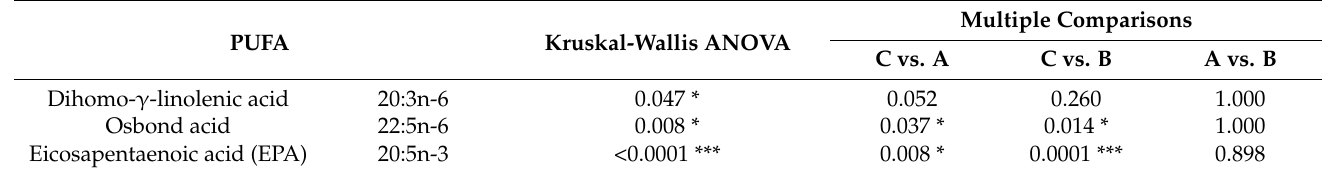
Table 2. Significant changes in PUFAs in plasma phospholipids. The numbers represent the p values.